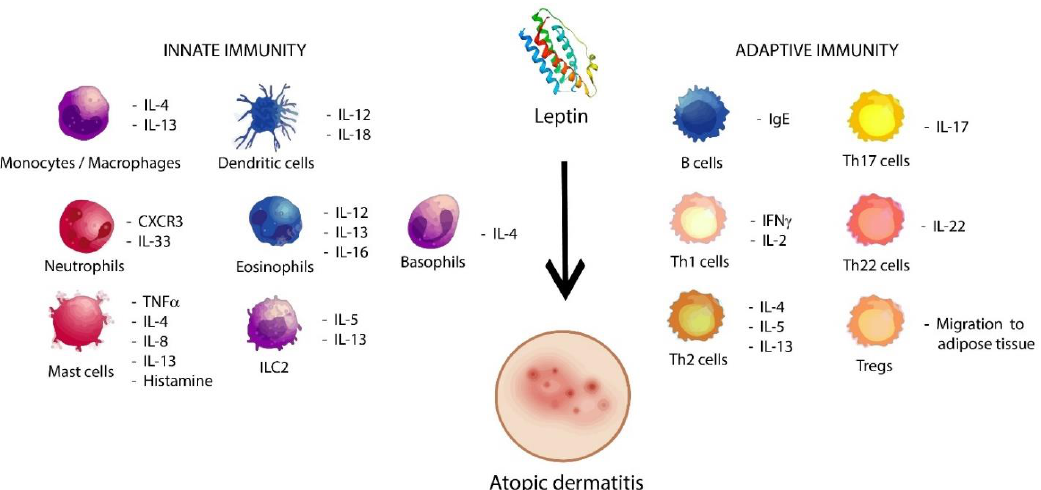
Figure 2. Probable role of leptin in atopic dermatitis. Leptin induces the activation of cells from both the innate and adaptive immunology system, which are able to promote the activation and proliferation of cytokines and other cells in pro-allergic conditions, such as Th2 immune responses, ILC2, and type 2 cytokines, thus contributing to atopic dermatitis.